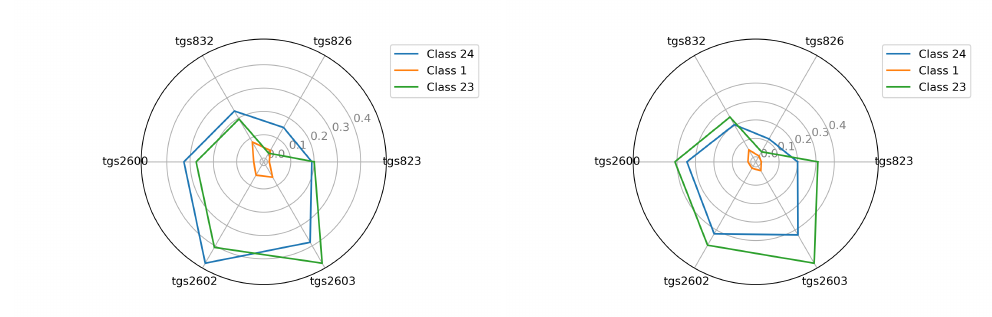
Figure 8. The visualization of the average reading intensity of TGS sensors for decision classes 1, 23, and 24 using M2; wooden chamber on the left and polystyrene chamber on the